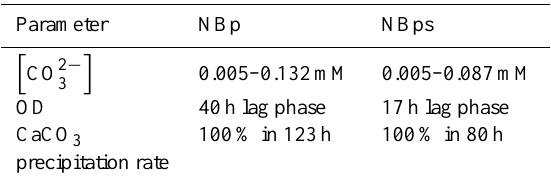
Table 1. Comparison of chemical and biological conditions be- tween coculture (NBps) and control (NBp) during the first 80h of the